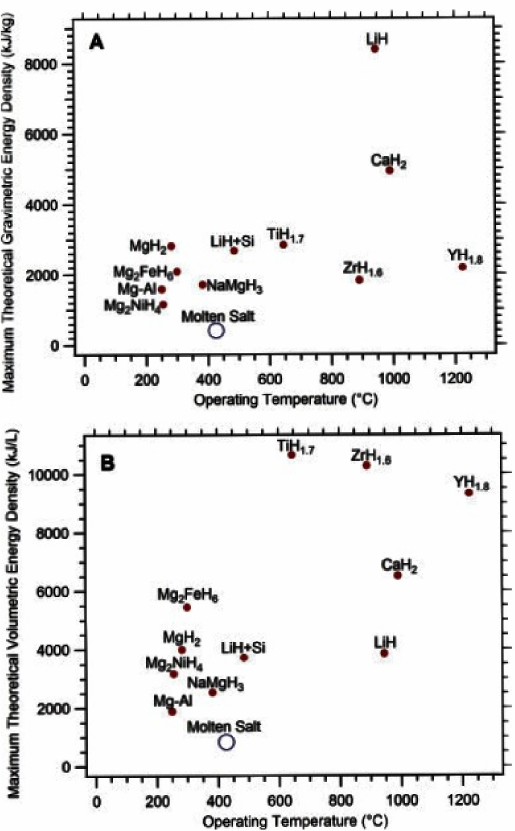
Figure 6. Maximum theoretical ( A ) gravimetric and ( B ) volumetric energy storage densities of select metal hydrides compared to existing molten salt technology